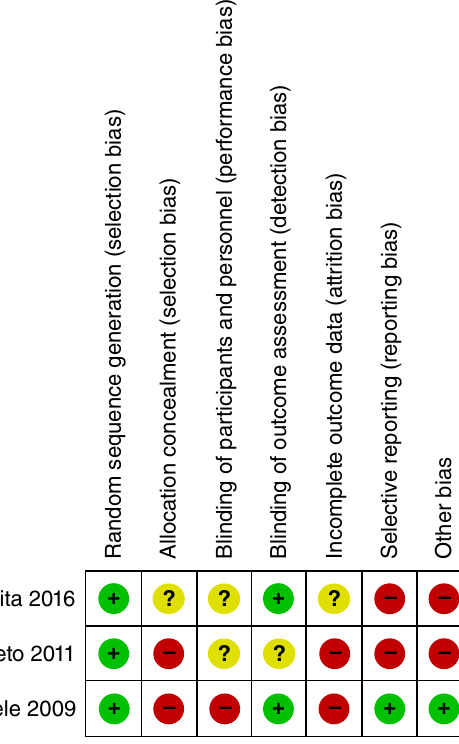
Figure 3. Risk of bias summary: review authors’ judgements about each risk of bias item for each included